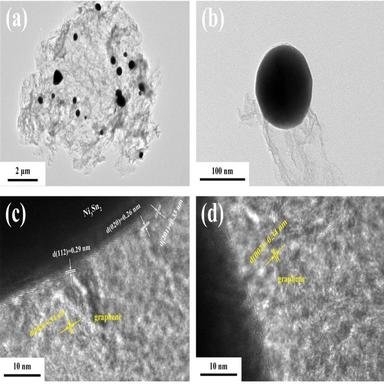
TEM images (a, b) and HRTEM images (c, d) of Ni3Sn2/NG.